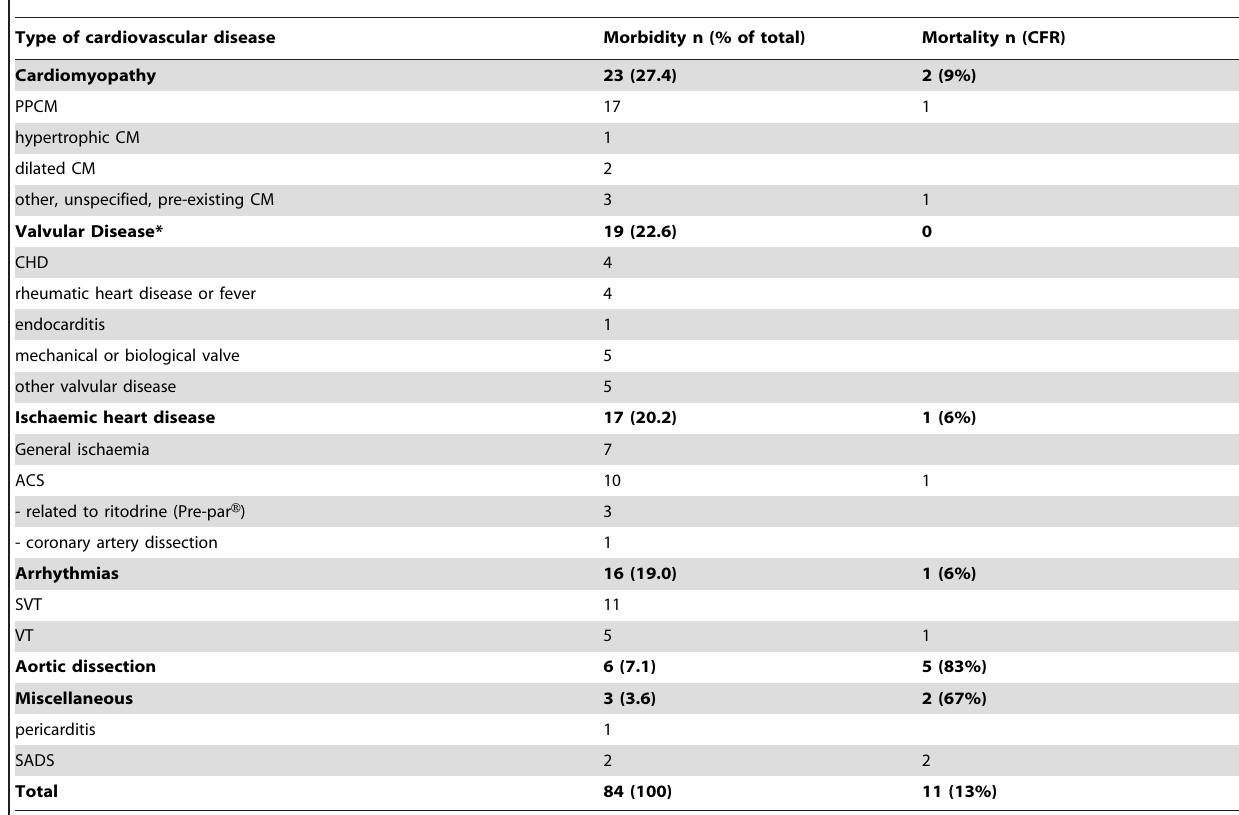
Table 1. Types of cardiovascular disease and its